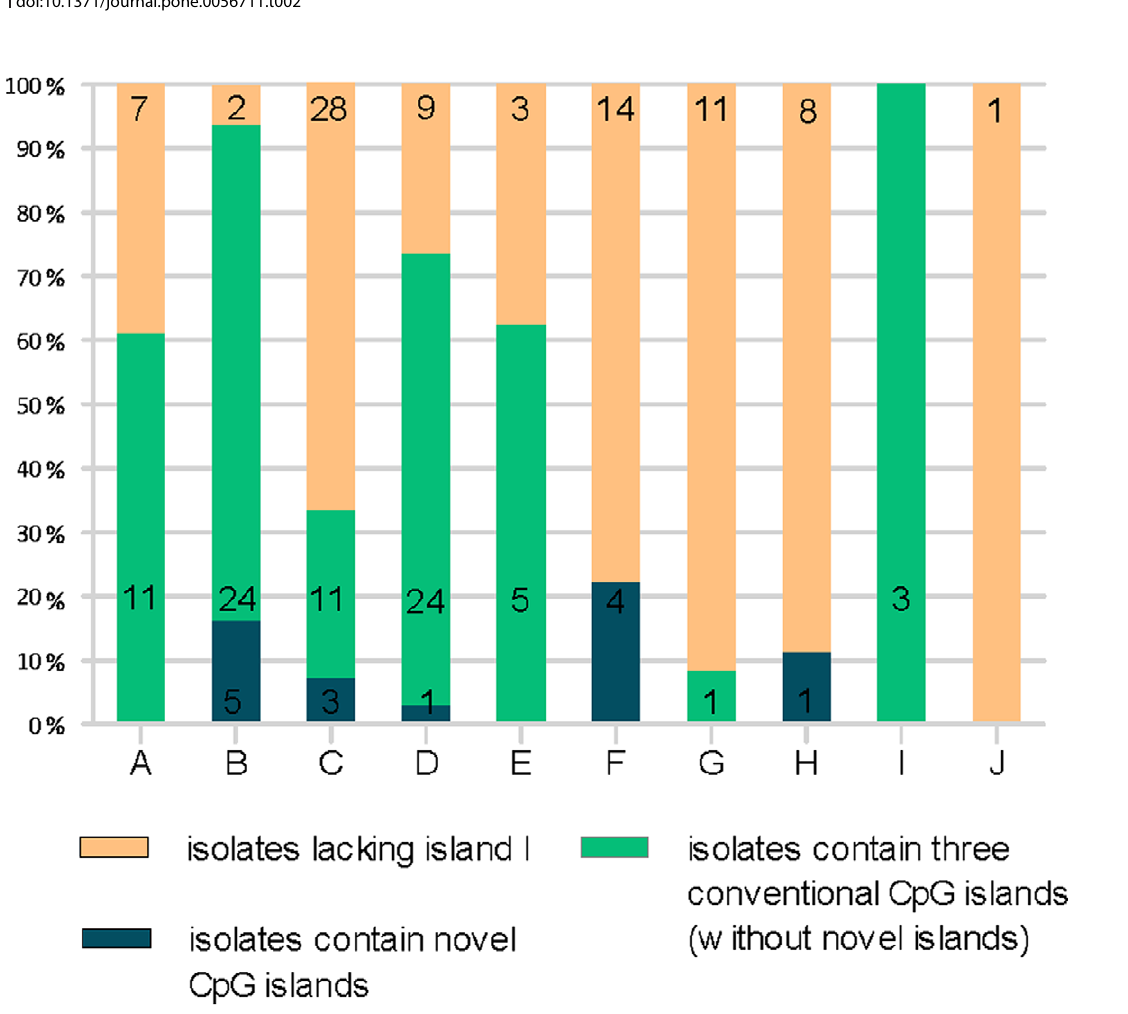
–, CpG island was absent. The first T of the Eco RI cleavage site is position 1. The numbering of the nucleotides was determined using an alignment of representative sequences of HBVs of the ten genotypes obtained from GenBank.